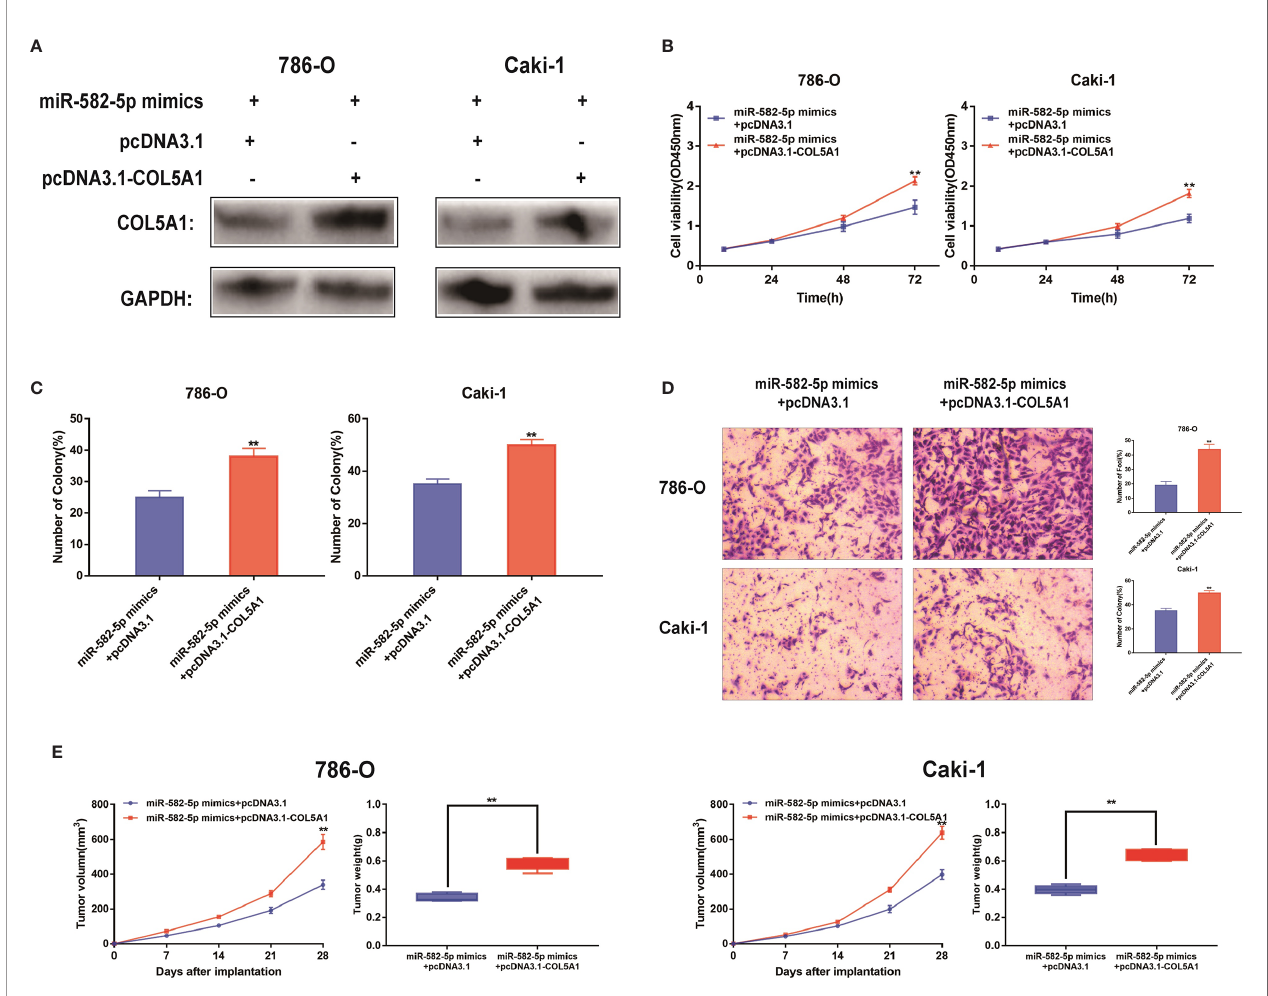
FIGURE 5 | Reconstitution of COL5A1 partially rescued the miR-582-5p-mediated effects. (A) Expression levels of COL5A1 in 786-O and Caki-1 cells which co- transfected with miR-582-5p mimics and pcDNA3.1-COL5A1 (or pcDNA3.1) were detected by western blot. GAPDH was used as an internal control. (B) CCK-8 assay of 786-O and Caki-1 cells in different transfected groups. (C) Cell proliferation was determined by colony-formation assay of different transfected groups in 786-O and Caki-1 cells. (D) Representative images revealing the invasion capacities of impacts of different transfected groups in 786-O and Caki-1 cells. (E) Tumor volume and weight were calculated of the xenograft tumors in subcutaneous xenograft mouse model injected with 786-O and Caki-1 cells co-transfected with COL5A1 and miR-582-5p mimics or co-transfected with vector and miR-582-5p mimics respectively. The data are shown as the mean ± SD (** P < 0.01). The experiments were repeated three times with similar